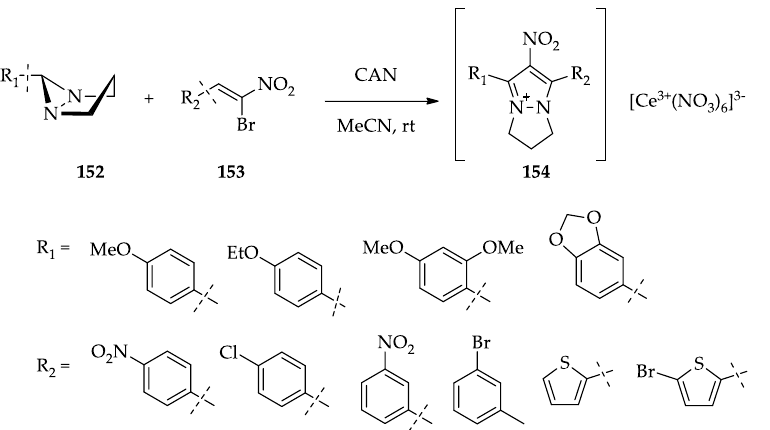
Figure 19. CAN-mediated synthesis of bicyclic cationic 154 with 2,3-dihydro-1H-pyrazolo[1,2-a]py-